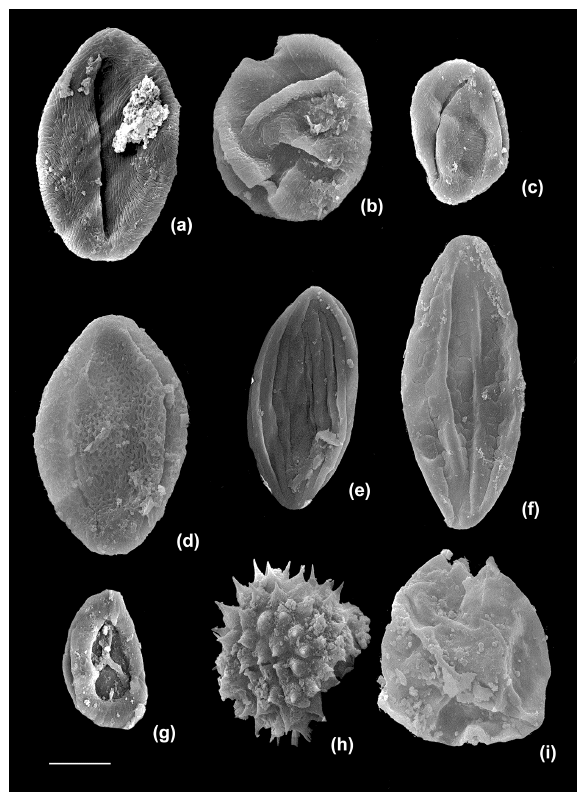
Plate 3. Scanning electron microscope (SEM) photographs of